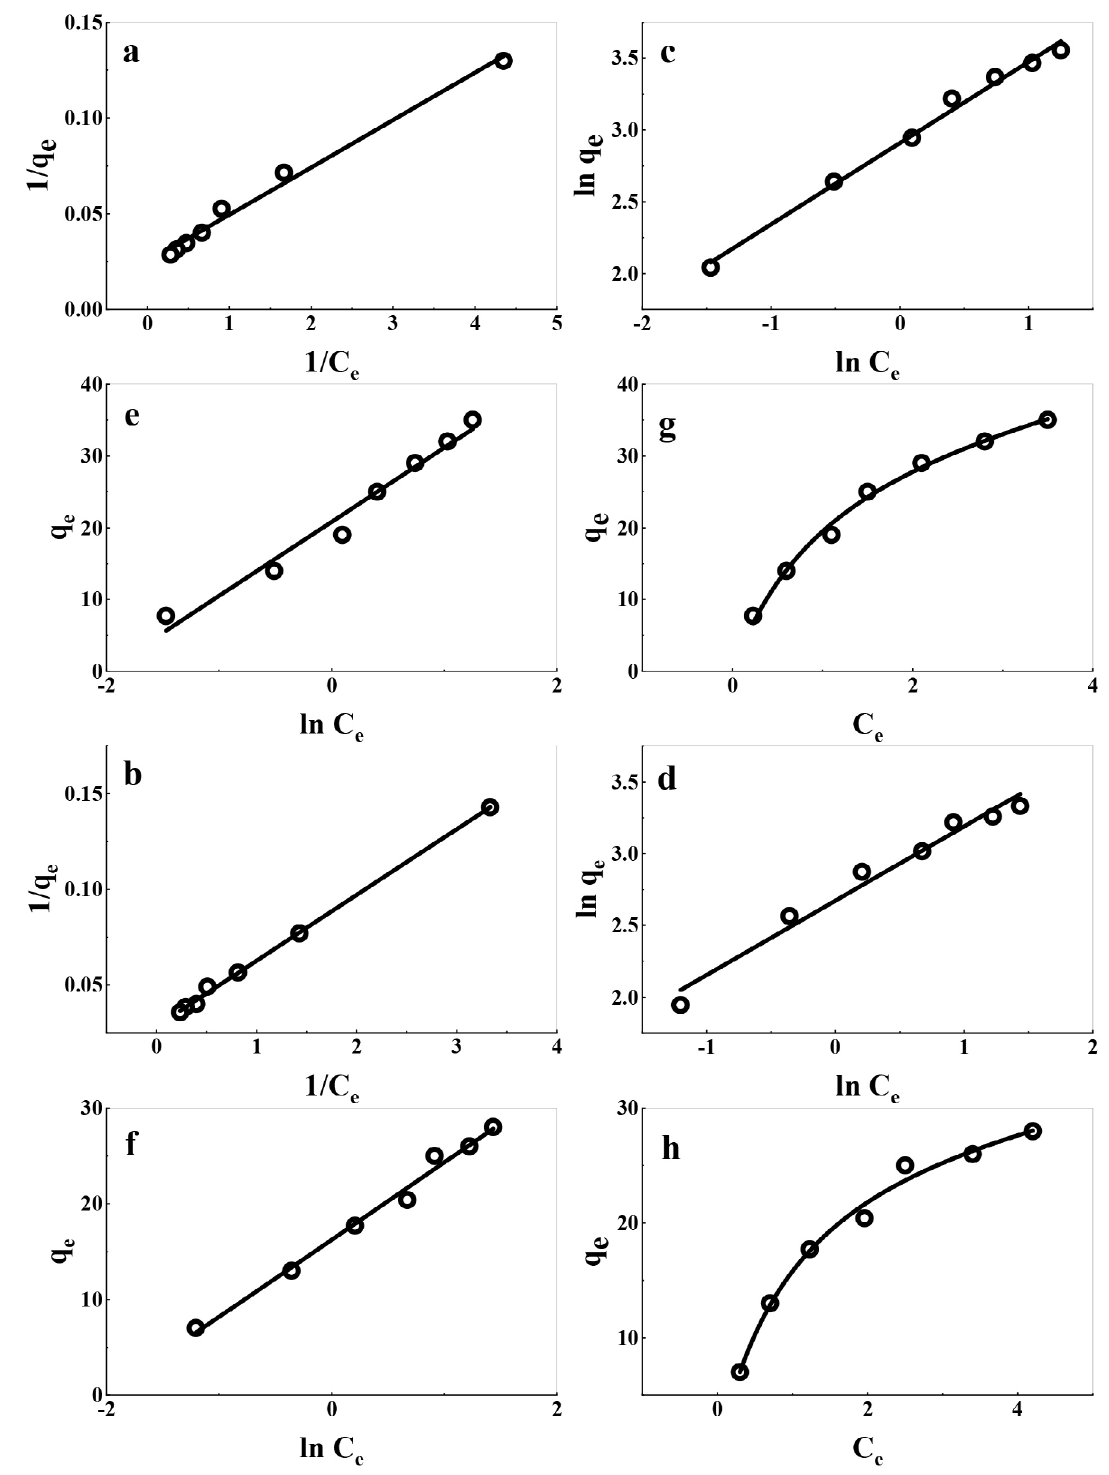
Fig. 7. (a–b) Langmuir; (c–d) Freundlich; (e–f) Temkin and (g–h) multilayer adsorption isotherms for adsorption of Fe(II) and Fe(III) onto SD/ PAni; a, c, e, and g represent adsorption data for linear plot of 1/ q e versus 1/ C e (Fig. 7a–b). The corre- adsorption data of Fe(II) fitted better compared to that sponding parameters are given in Table 1. Both iso- of Fe(III). The separation factor which describes the therm data sets were well fitted to Langmuir model but feasibility of the adsorption was calculated by the fol -